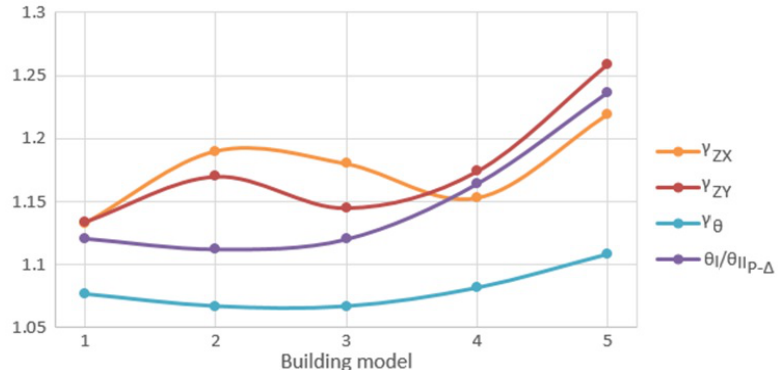
Figure 10. Comparison on the parameters behavior (first